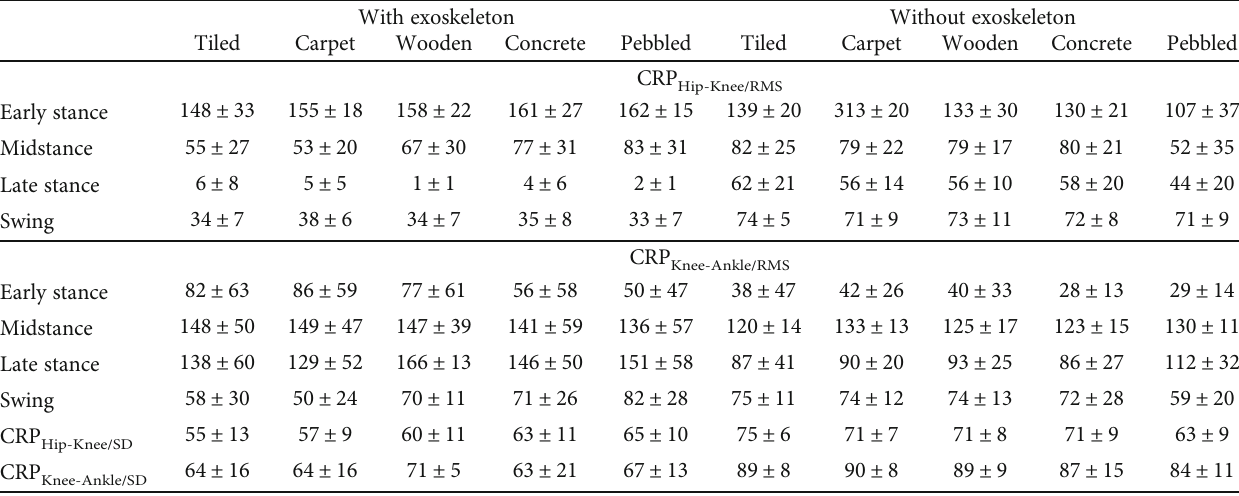
Table 3: Coordination: CRP root mean square (CRP ) and variability (CRP ) over the full gait cycle for participants ( n = 8 ) with/without RMS SD exoskeleton over the gait cycle on each kind of pavements. With exoskeleton Without exoskeleton Tiled Carpet Wooden Concrete Pebbled Tiled Carpet Wooden Concrete Pebbled CRP